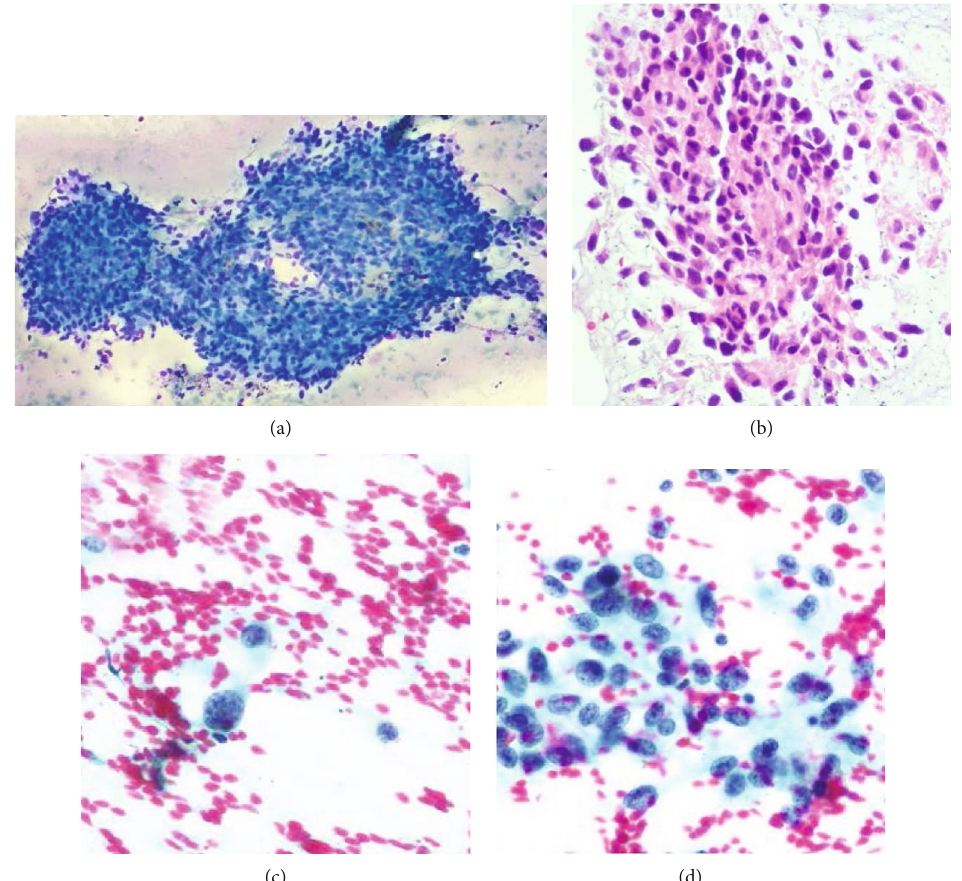
Figure 3: Di ff -Quik smear shows clusters of cohesive neoplastic, epithelioid cells with a small amount of cytoplasm (a). The alcoholol- fi xed smears demonstrate individual and clustered neoplastic cells with coarse chromatin, ill-de fi ned borders, and nuclear grooves (c, d). The corresponding cellblock material is shown in